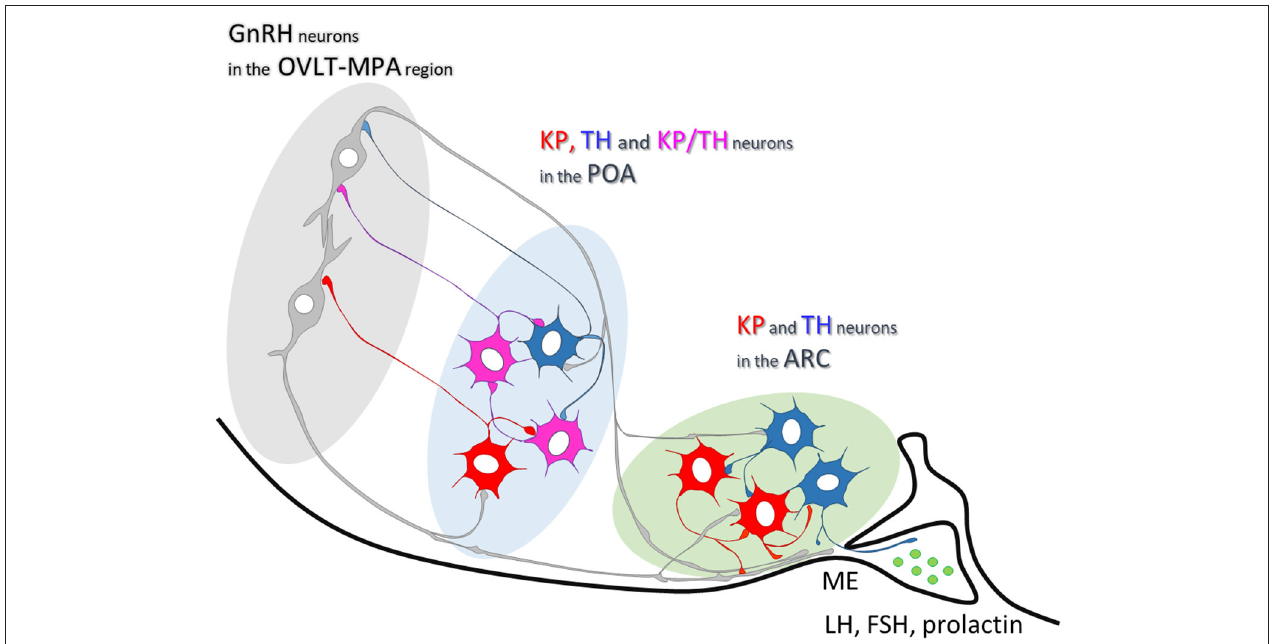
FIGURE 6 | Summary scheme illustrating neuronal interactions between GnRH and dopaminergic neurons in mice. In the mouse preoptic area, about two-thirds of TH-IR neurons are also immunoreactive for KP. One-third of them, similarly to the Arc dopaminergic neurons, are distinct from KP-IR neurons. Axonal branches of GnRH processes establish synaptic connections with the TH- and KP-IR cell populations in both the preoptic area and arcuate